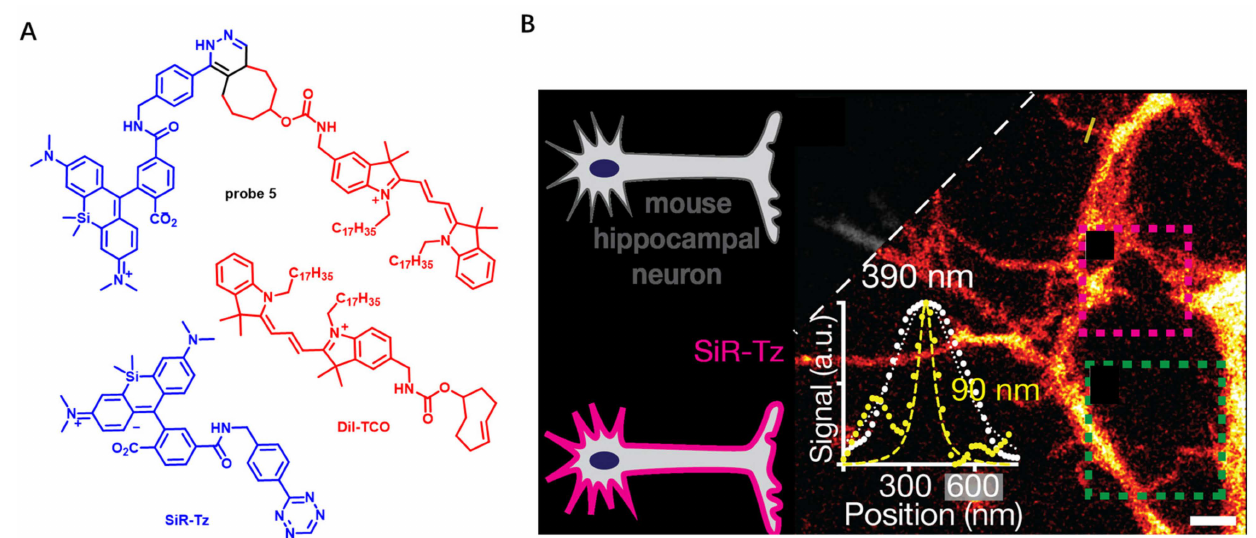
Figure 4. ( A ) Chemical structures of probe 5 , DiI-TCO and SiR-Tz. ( B ) STED imaging of DIV 4 mouse hippocampal neurons with DiI-SiR. Scale bar: 2 µ m. Copyright 2017 John Wiley and Sons